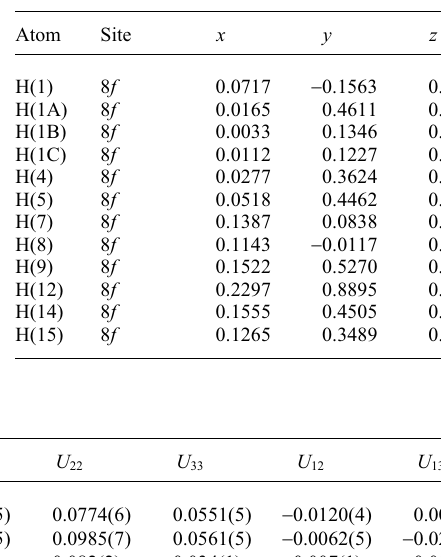
Table 2. Atomic coordinates and displacement parameters (in Å 2 ) .